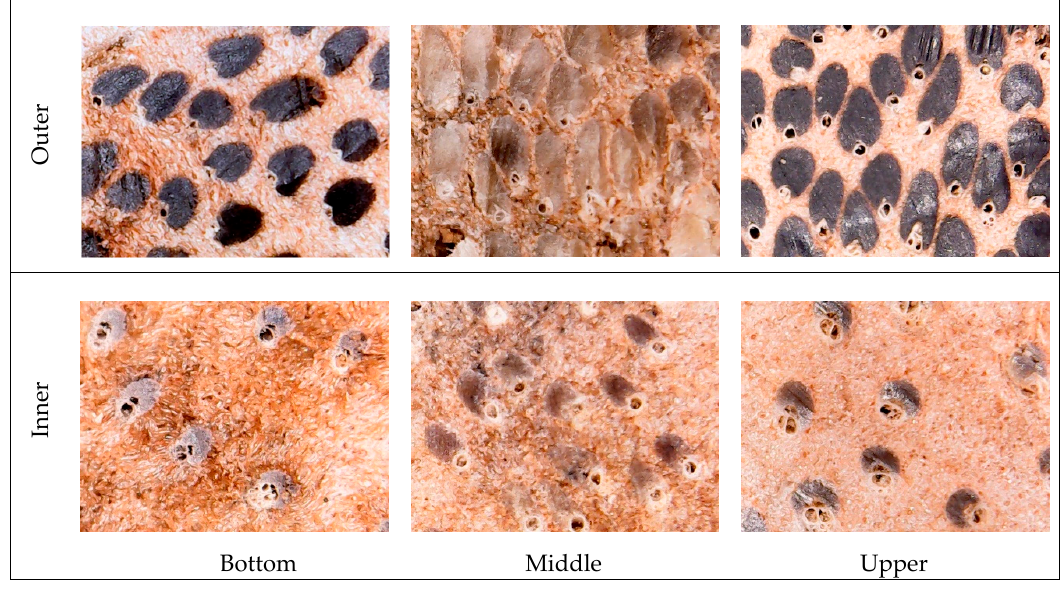
Figure 4. Macroscopic images (20×) of gewang wood.